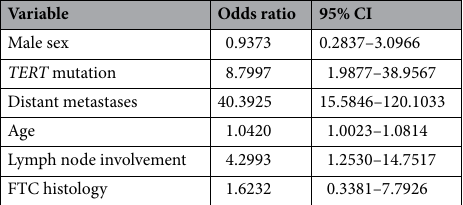
Table 3. Odds ratios and 95% confidence intervals (CI) at logistic regression analysis, referred to the outcome (persistent disease or disease-related